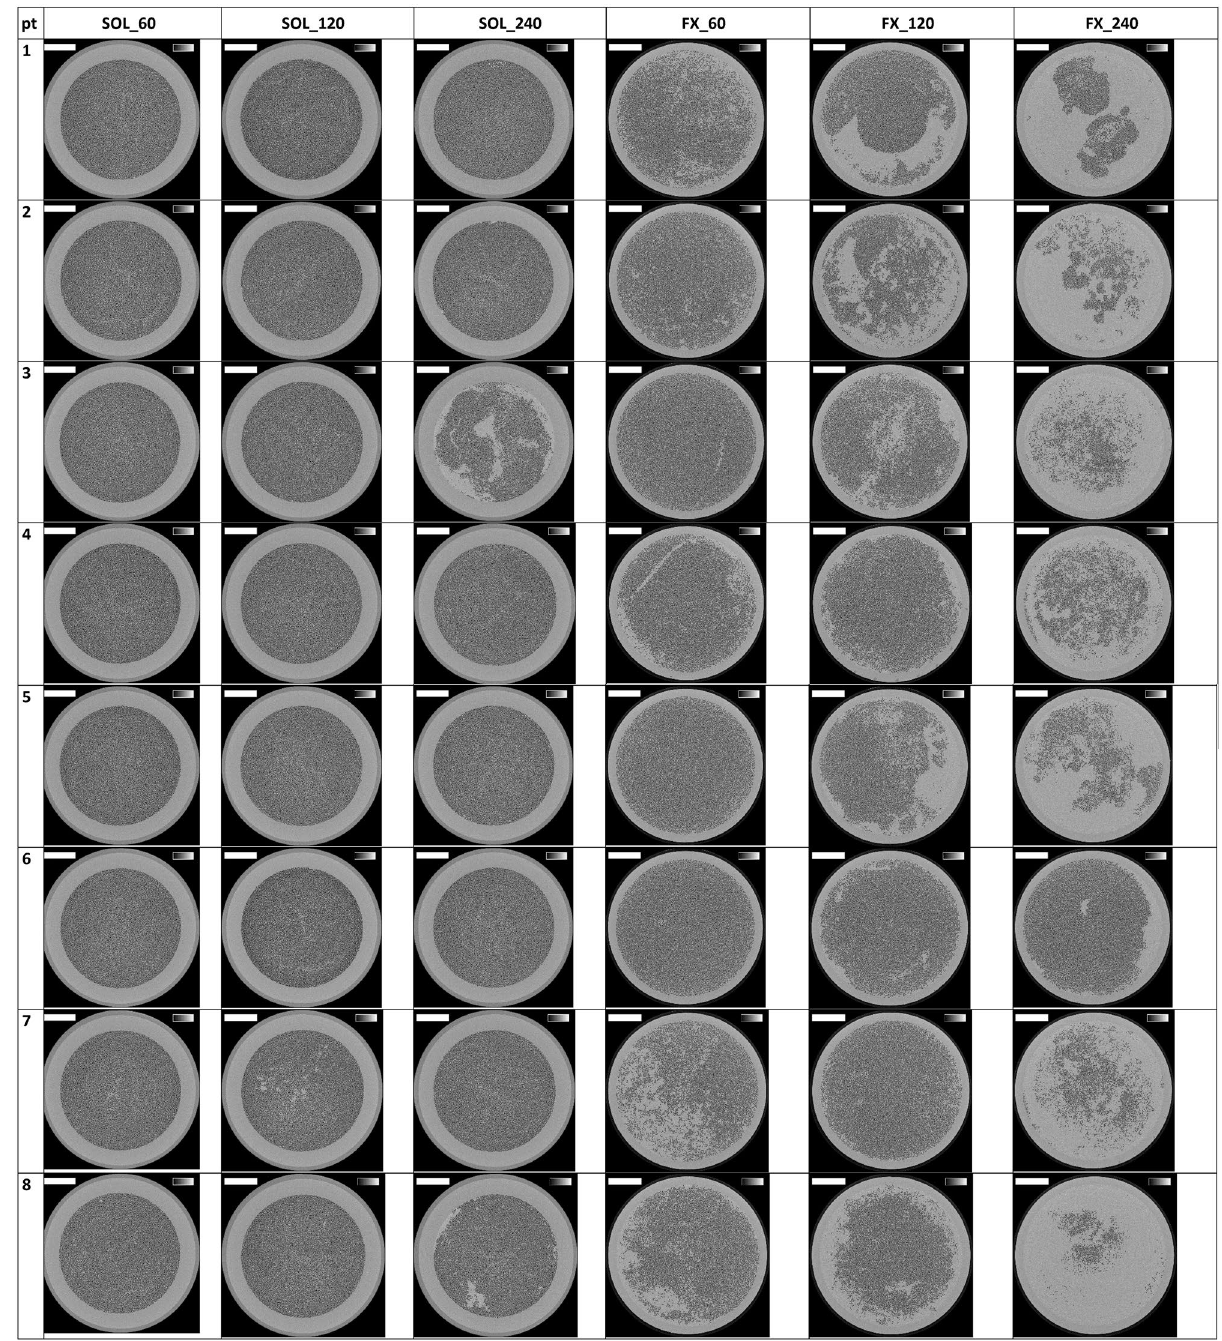
Figure 1. Cross-sections halfway the outlet potting in 10 patients, 2 dialyzers and for each 3 dialysis durations. The greyscale range is from 0 to 0.5 cm -1 and the scale bar denotes 10